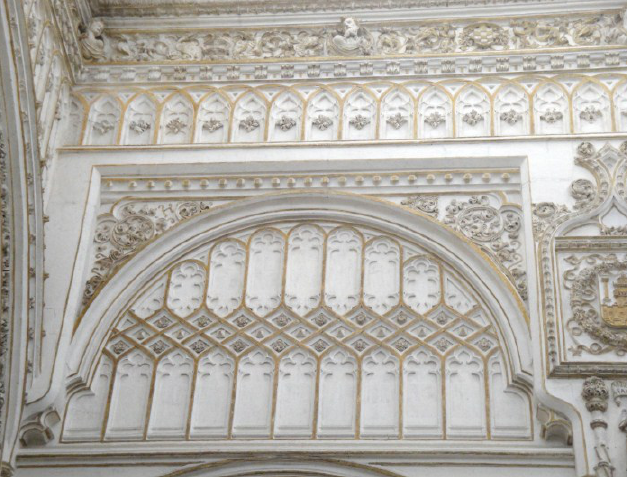
Figure 3. Hernan Ruiz I. Transept. Mosque-Cathedral (Cordoba). Photo took by author.